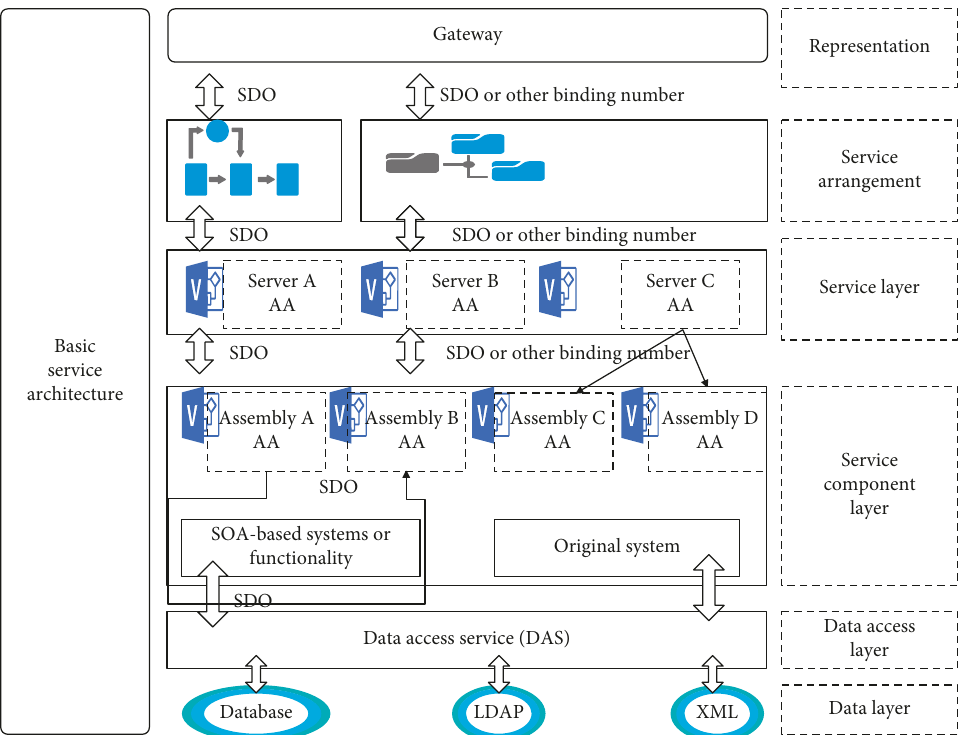
Figure 6: Architecture model of AI English teaching resource integration system.